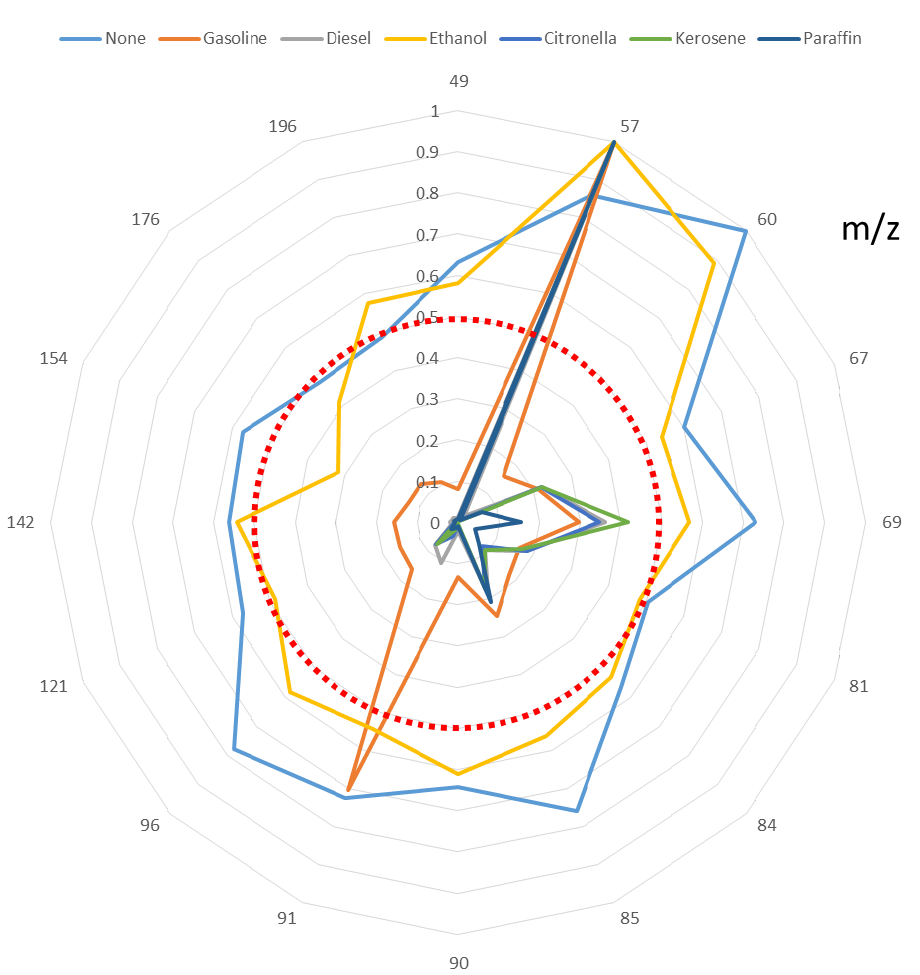
Figure 5. ILR fingerprints obtained by displaying the m / z values selected in the LDA. The red line represents 50% of the highest value.